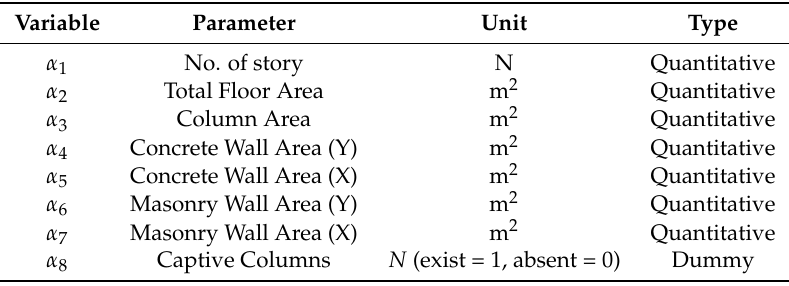
Table 2. Parameters for earthquake hazard safety assessment